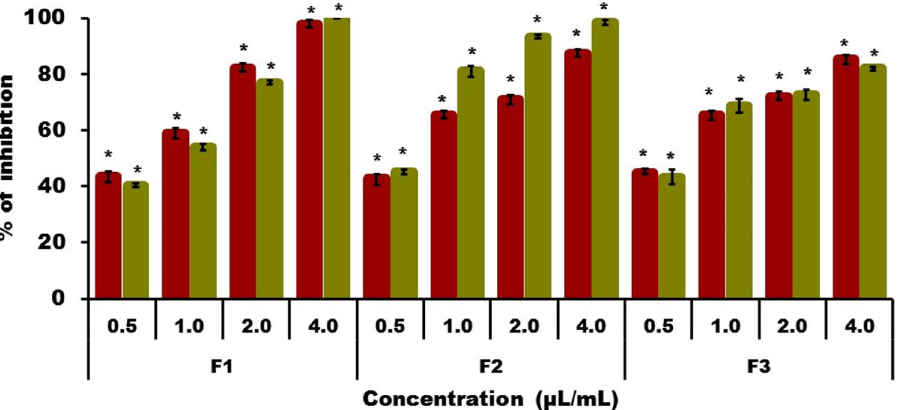
Figure 5. Effect of essential oils on the growth of three Fusarium strains. Percentage of inhibition of Fusarium sporotrichioides (F1), Fusarium moniliforme (F2), and Fusarium solani (F3) growing on cherry tomatoes exposed to Bursera morelensis (red) and Lippia graveolens (green) essential oils at concentrations of 0.5, 1.0, 2.0, and 4.0 µL/mL. *Statistically significant values of mean with respect to the control (P <